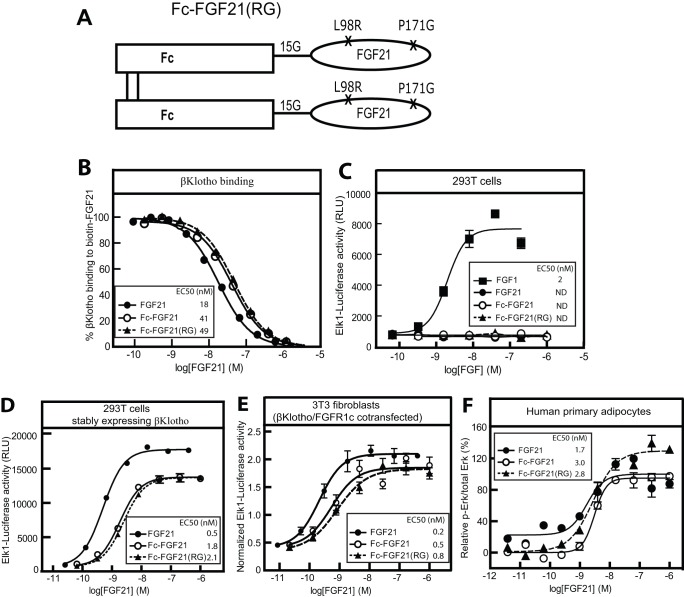
In vitro activity of Fc-FGF21(RG) relative to native FGF21 and Fc-FGF21 wild type.(A) Structural diagram of Fc-FGF21(RG), an E coli-expressed homodimeric Fc-FGF21 fusion protein containing 2 engineered point mutations at positions 98 and 171. 15G indicates the 15 aa polyglycine and polyserine linker. (B) The binding activity of FGF21, Fc-FGF21 and Fc-FGF21(RG) to human βKlotho determined in a solution equilibrium binding assay on a BIAcore instrument. (C) Elk1-luciferase reporter activity in 293T cells treated with FGF1, FGF21, Fc-FGF21 and Fc-FGF21(RG). The cells were stably expressing reporter constructs but no βKlotho. (D) Stimulation of Elk1-luciferase reporter activity by FGF21, Fc-FGF21 and Fc-FGF21(RG) in 293T cells stably expressing human βKlotho along with luciferase reporter constructs. (E) Stimulation of Elk1-luciferase reporter activity by FGF21, Fc-FGF21 and Fc-FGF21(RG) in mouse NIH/3T3 fibroblast cells transiently co-transfected with human βKlotho and human FGFR1c. (F) Stimulation of Erk phosphorylation by FGF21, Fc-FGF21 and Fc-FGF21(RG) in human primary adipocytes. All data represent mean ± SEM, n = 4/concentration group. ND: not detectable. FGF21, closed circle; Fc-FGF21: opened circle; Fc-FGF21(RG): closed triangular and dash line; FGF1: closed square.